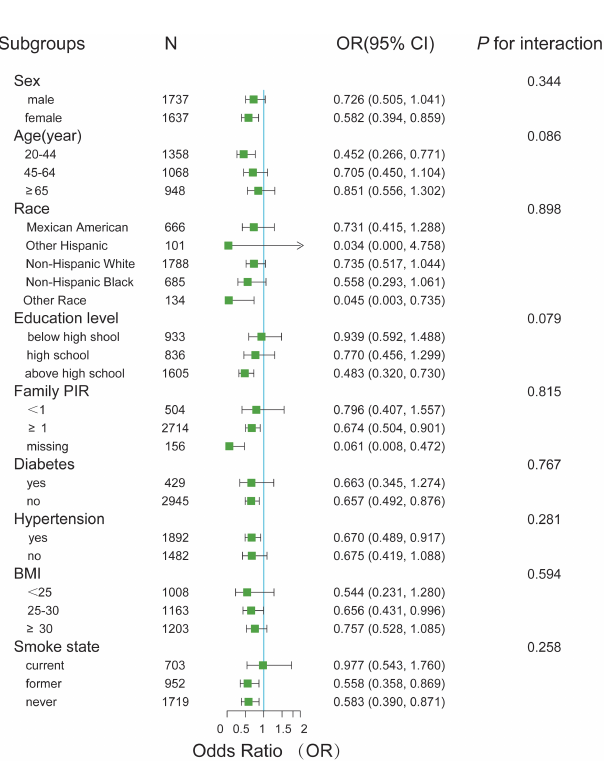
Figure 3. Forest plots of the association between serum vitamin C and the risk of NAFLD in various subgroups. Adjust for age, gender, race, education level, family PIR, body mass index, hypertension, diabetes, total cholesterol, triglyceride, smoke state, vitamin A, vitamin E, except for the stratifying variable. NAFLD, non-alcoholic fatty liver disease; PIR, poverty-to-income